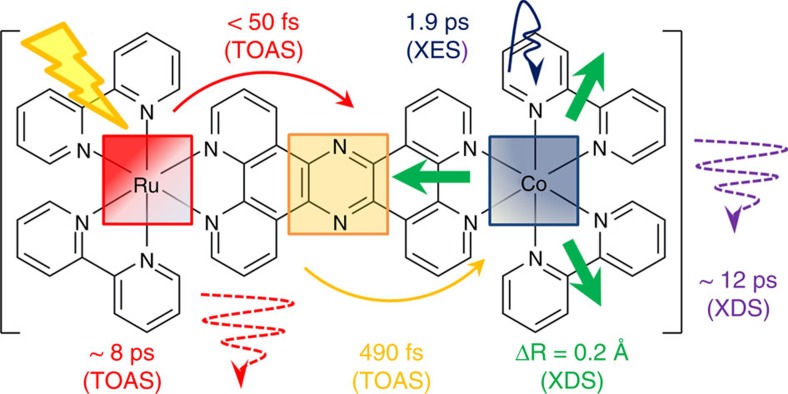
Non-equilibrated ET across the photoexcited [1RuII=1CoIII] dyad.The schematic summarizes the fundamental timescales, as obtained from TOAS and combined XES–XDS at the SACLA XFEL facility.